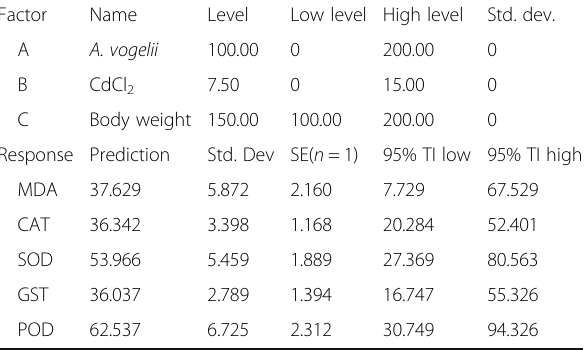
Table 4 Validation of response surface quadratic